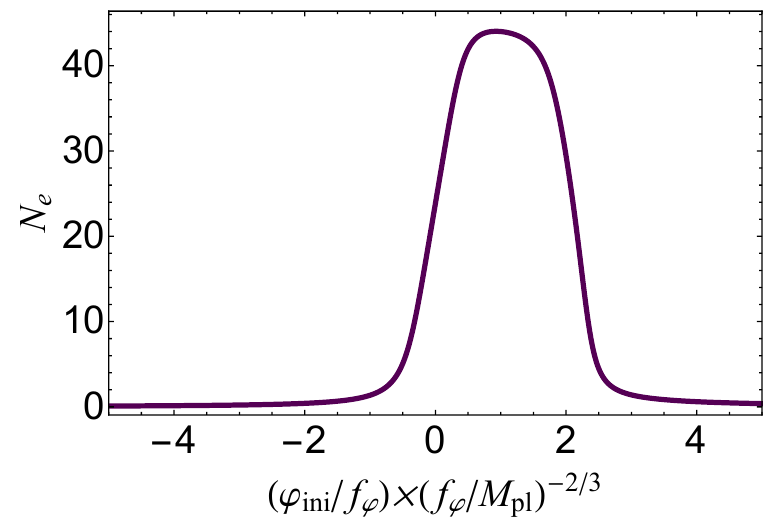
Figure 6 . Total e-folding number obtained by varying ϕ ini . Here f ϕ = 0 . 3 MeV , δ = 0 . 0365 × ( f ϕ /M pl ) 8 / 3 which results H inf ≈ 5 × 10 − 15 eV